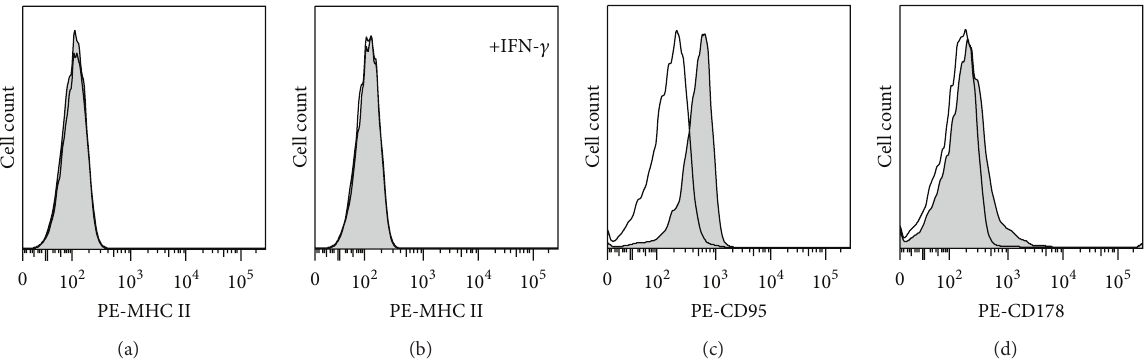
Figure 3: Flow cytometry analysis of 12B1 cells for the expression of MHC class II, Fas (CD95) and FasL (CD178), (a) cells treated with anti- MHC class II antibody, (b) cells cultivated in the presence of INF- 𝛾 and treated with MHC class II antibody, (c) cells treated with anti-Fas (CD 95) antibody, and (d) cells treated with anti-FasL (CD 178) antibody. Grey histograms indicate cells treated with the respective antibody. Empty histograms represent cells treated with the appropriate isotype